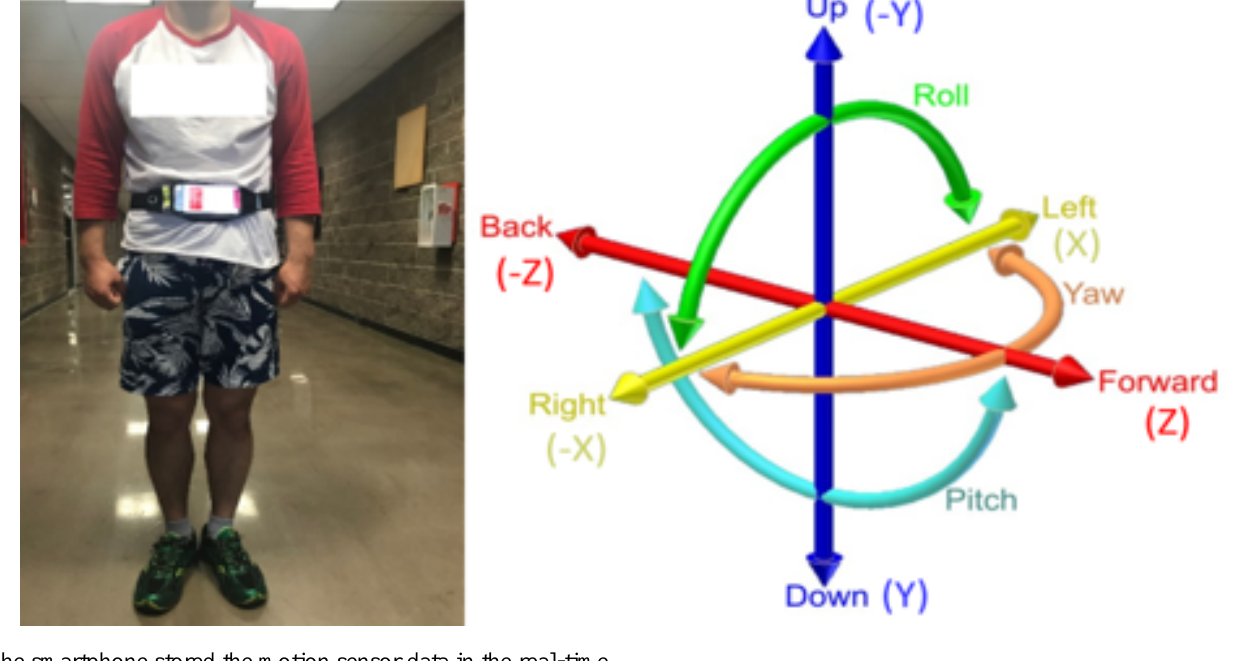
Figure 8. XYZ-axis orientations of the smartphone during the walking balance test. X-axis is the right (−) and left (+) motions of the participant. Y-axis is the up (−) and down (+) motions of the participant. Z-axis is the forward (+) and backward (−) motions of the